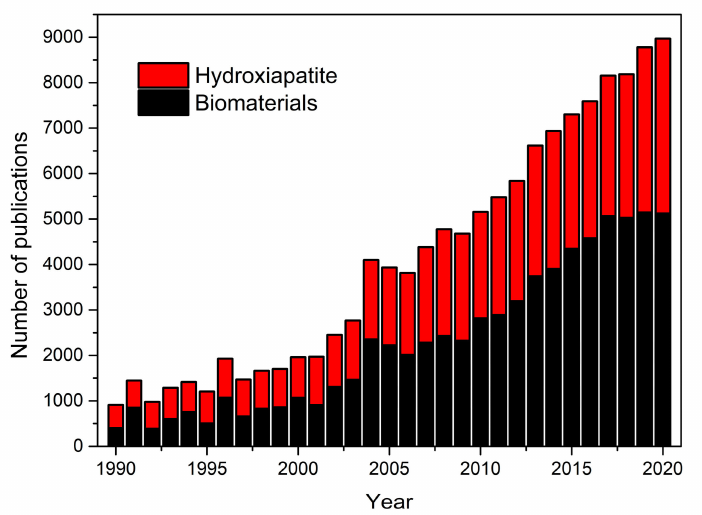
Figure 1. Scientific publications from 1990 to 2202 based on a Scopus database search performed in March 2021 on the topics “Biomaterials” and “Hydroxyapatite”